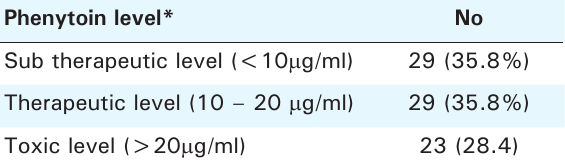
Table 1. Serum Phenytoin level (n-81)